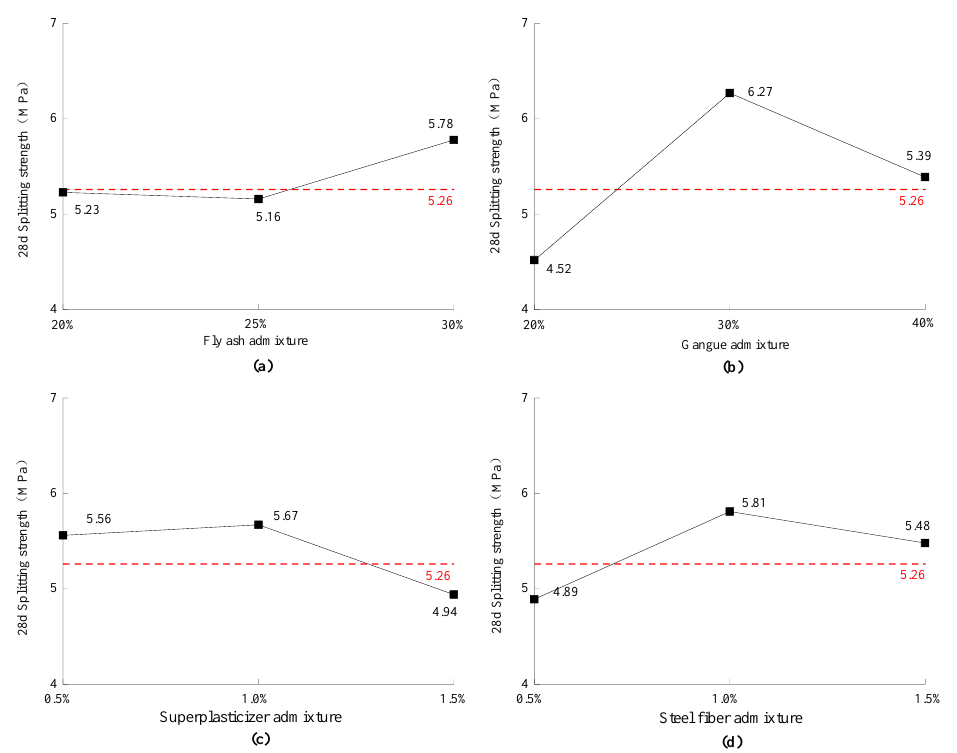
Figure 18. Influence of various factors on concrete splitting strength. ( a ) The influence of fly ash on the splitting strength of concrete. ( b ) The influence of gangue on the splitting strength of concrete. ( c ) The influence of superplasticizer on the splitting strength of concrete. ( d ) The influence of steel fiber on the splitting strength of concrete.